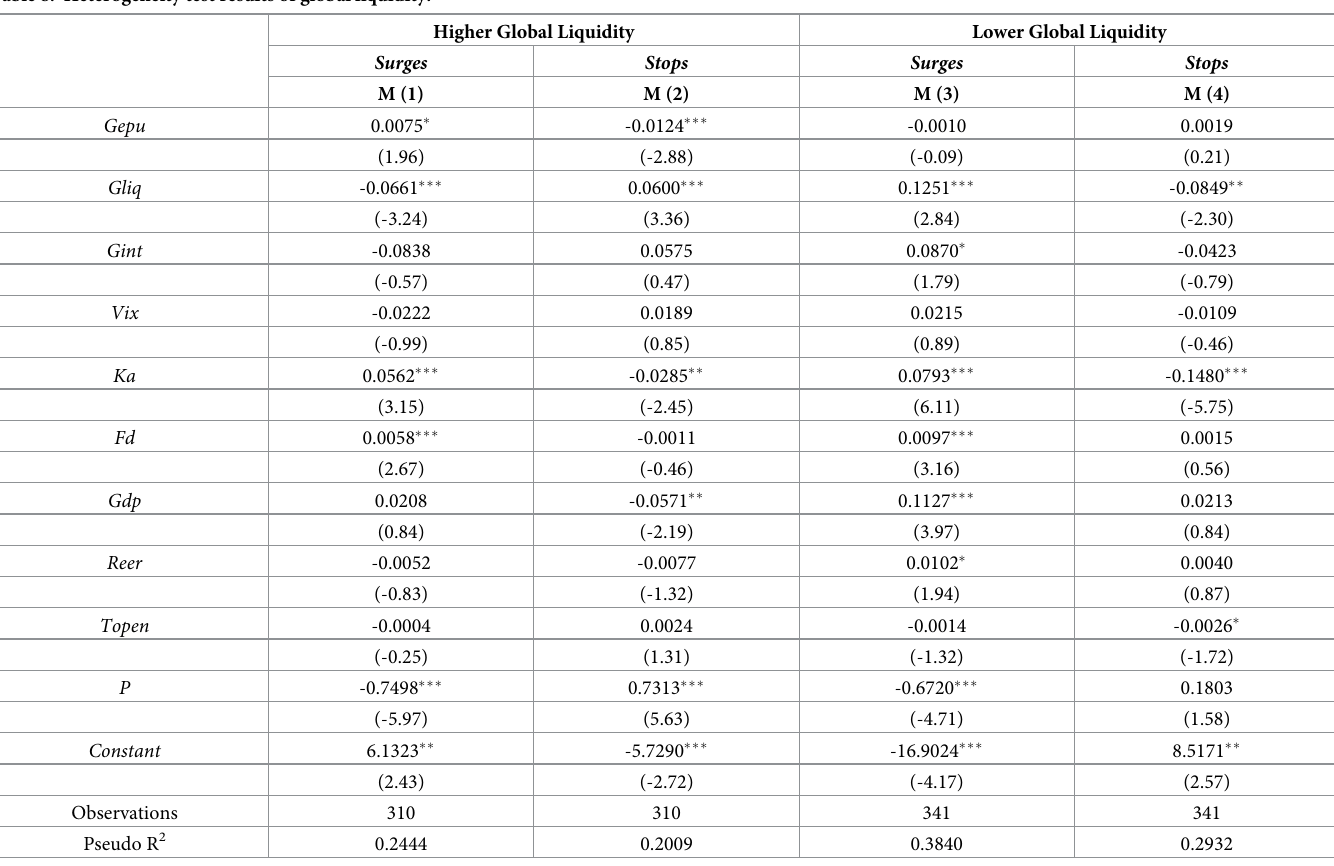
Table 8. Heterogeneity test results of global